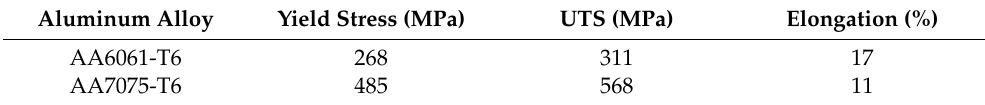
Table 2. Mechanical properties of AA6061-T6 and AA7075-T6 Aluminum alloys. Aluminum Alloy